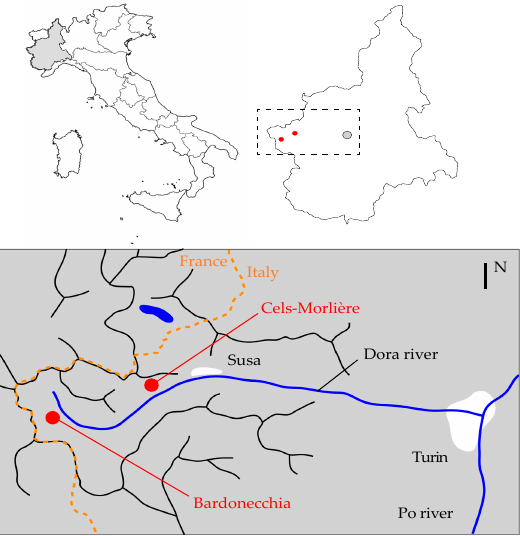
Figure 13. Geographic framework of the two study cases.